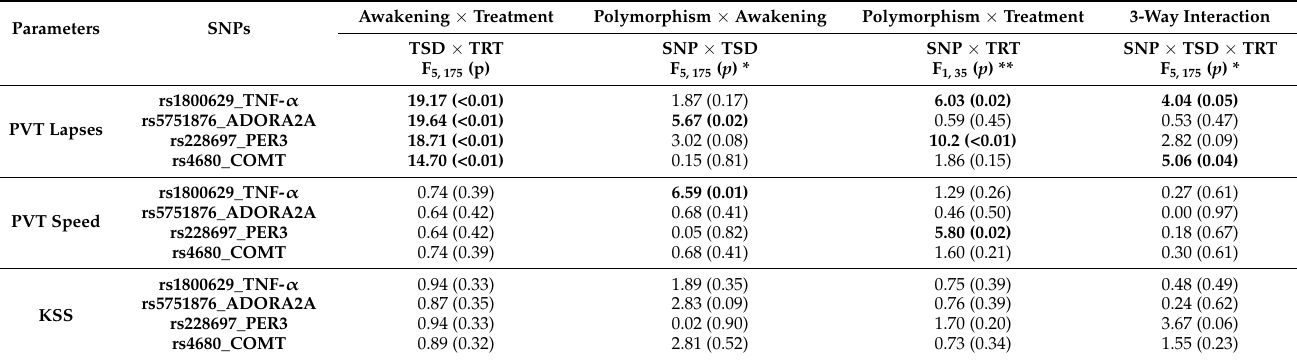
Table 2. ANOVA analysis of genetic polymorphism (SNPs) in interaction with awakening (TSD) and treatment (TRT) on PVT (psychomotor vigilance task) parameters (number of lapses and speed) and KSS score. Parameters